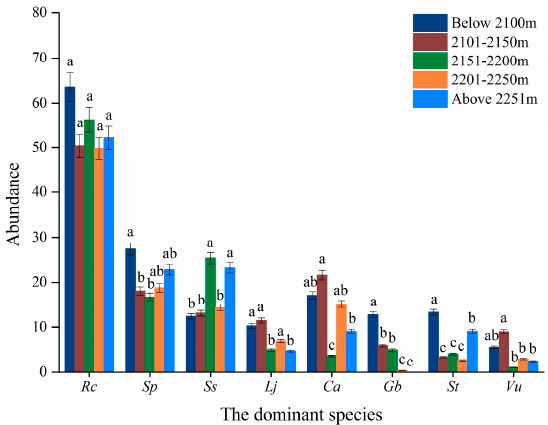
Figure 1. The abundance of the eight dominant species in relation to elevations. Note: Rc, indicate